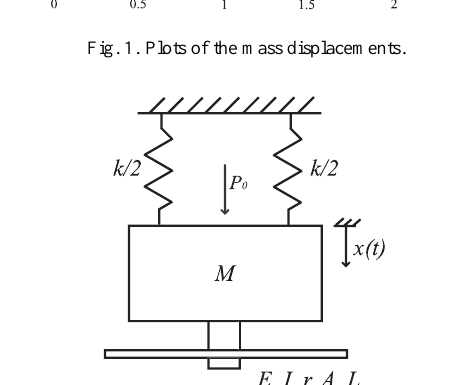
Fig. 1. Plots of the mass displacements.